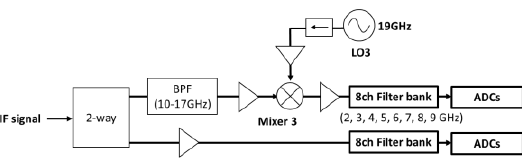
Fig. 8. Schematic diagram of IF section.